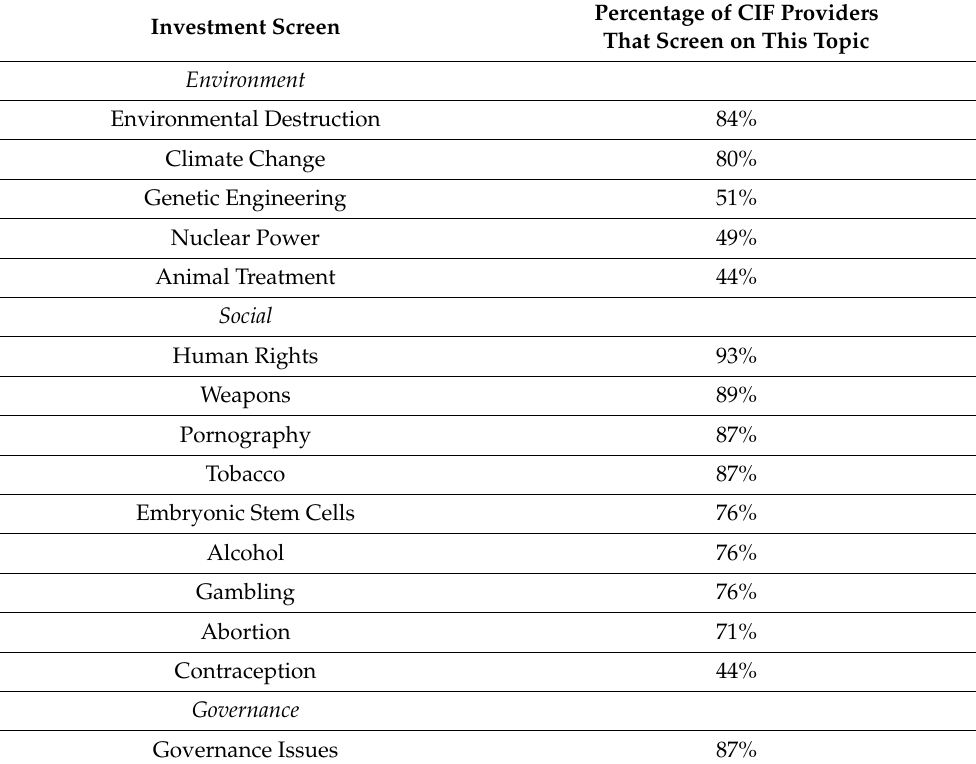
Table 2. Summary of the topics of concern for CIF